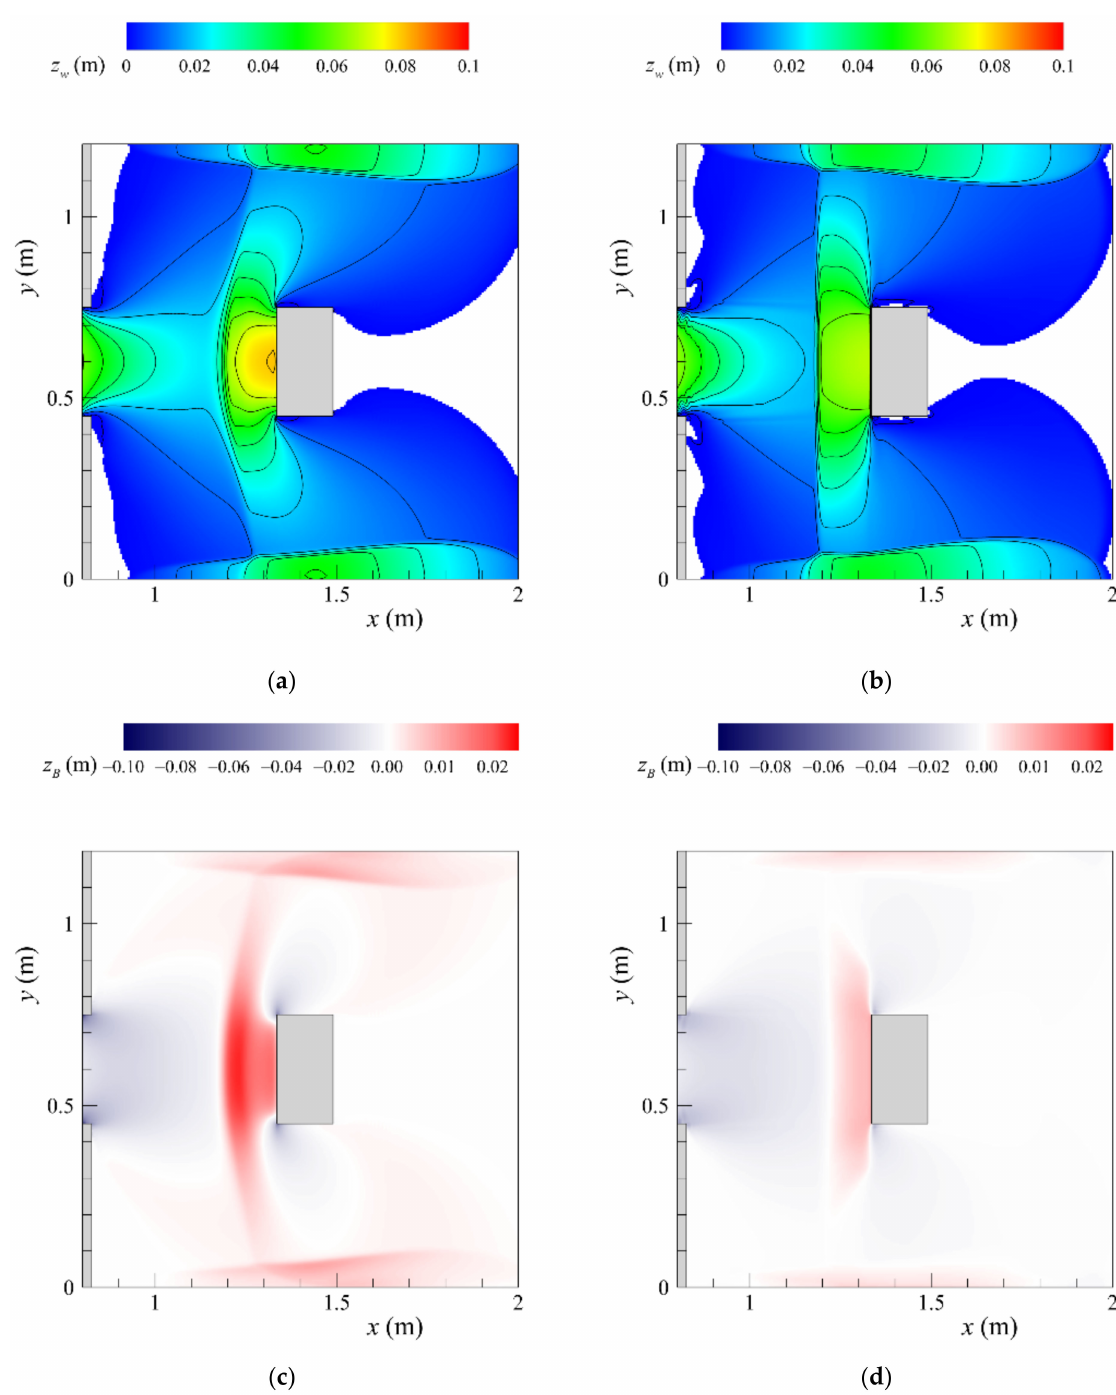
Figure 9. Results for PVC particles d = 5 × 10 − 4 m at t = 1.5 s: ( a ) free-surface elevation predicted by the SVEM; ( b ) free-surface elevation predicted by the TPM; ( c ) bottom elevation predicted by the SVEM; ( d ) bottom elevation predicted by the